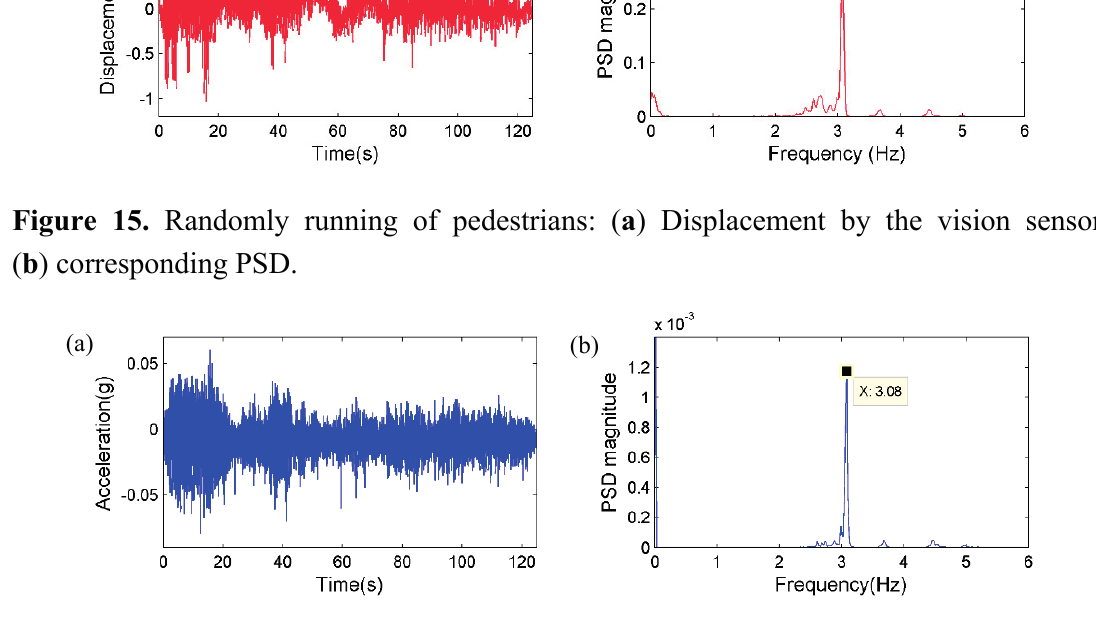
Figure 16. Randomly running of pedestrians: ( a ) Acceleration measurement; ( b ) Corresponding